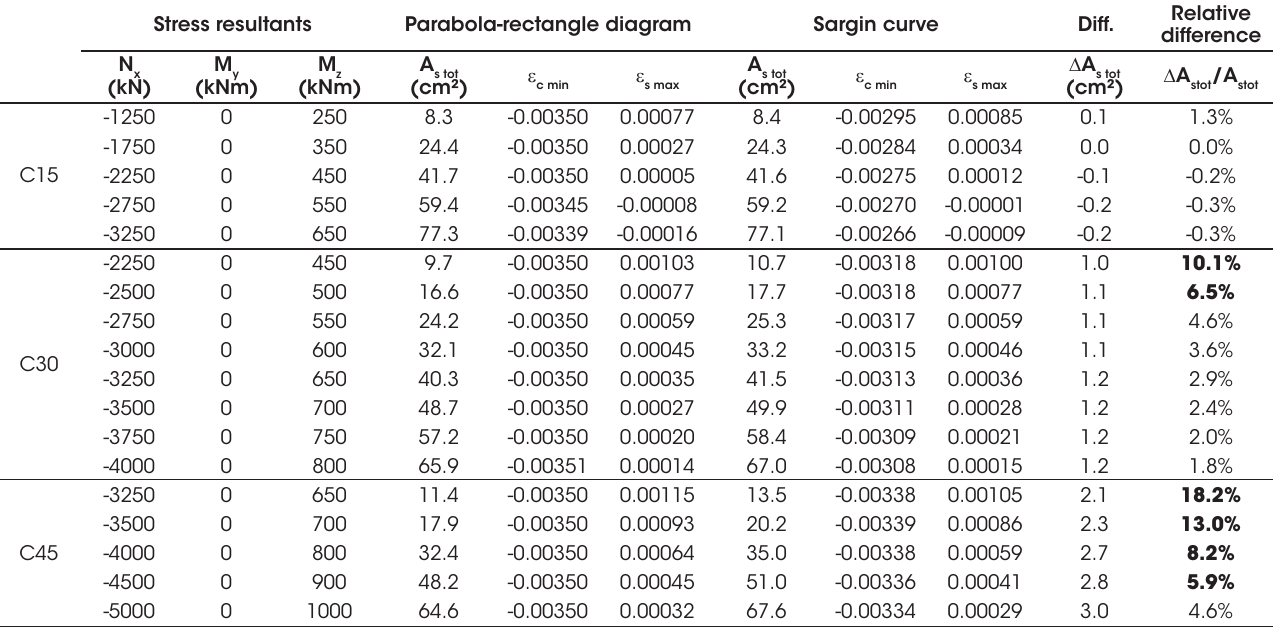
Doubly-reinforced cross-section subjected to compression and uniaxial bending (e Stress resultants Parabola-rectangle diagram Sargin curve Diff.